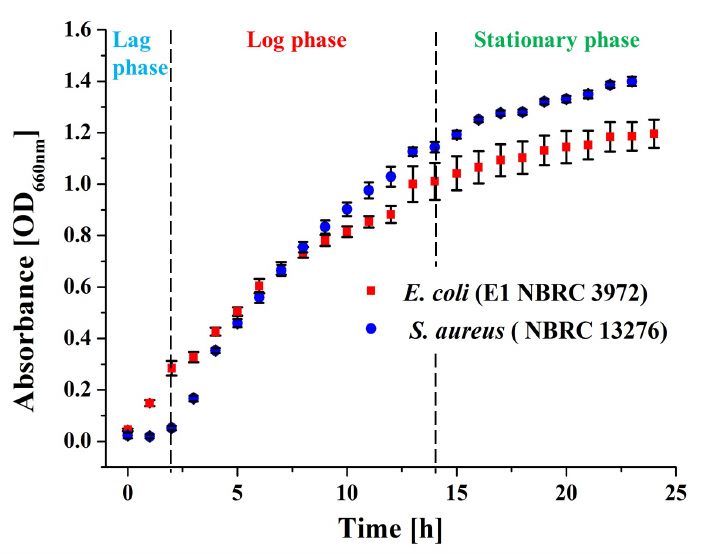
Figure 2. Microbial growth curves of E. coli and S. aureus indicating the three main periods of microbial activity, namely, the lag phase, log phase and stationary phase, based on optical density values collected by the miniphoto 518R photometer. Table 1. Abbreviations of various types of antibacterial agents of bamboo based on their location, species and concentration.